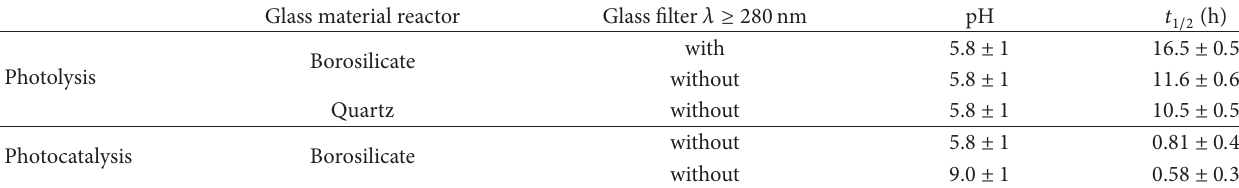
Table 2: Kinetics of metoprolol UV-C photodegradation under different conditions.